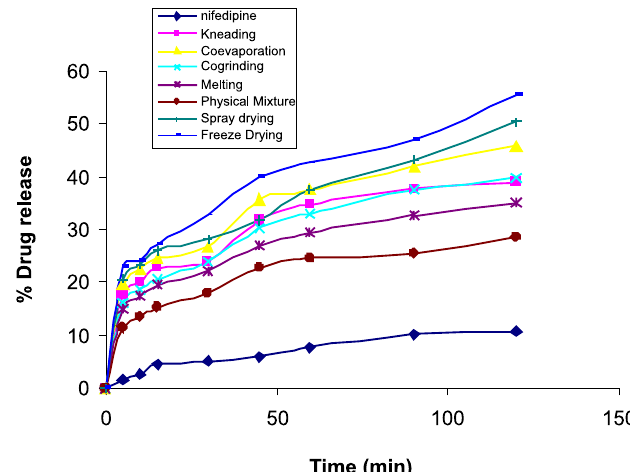
Distilled Water.